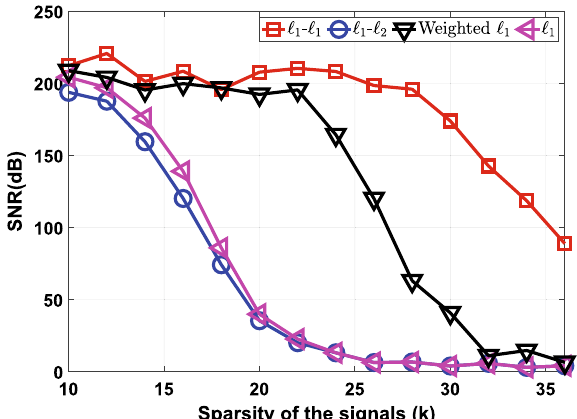
Fig. 4 Recovery performance of four models under different sparsity of the desired signals